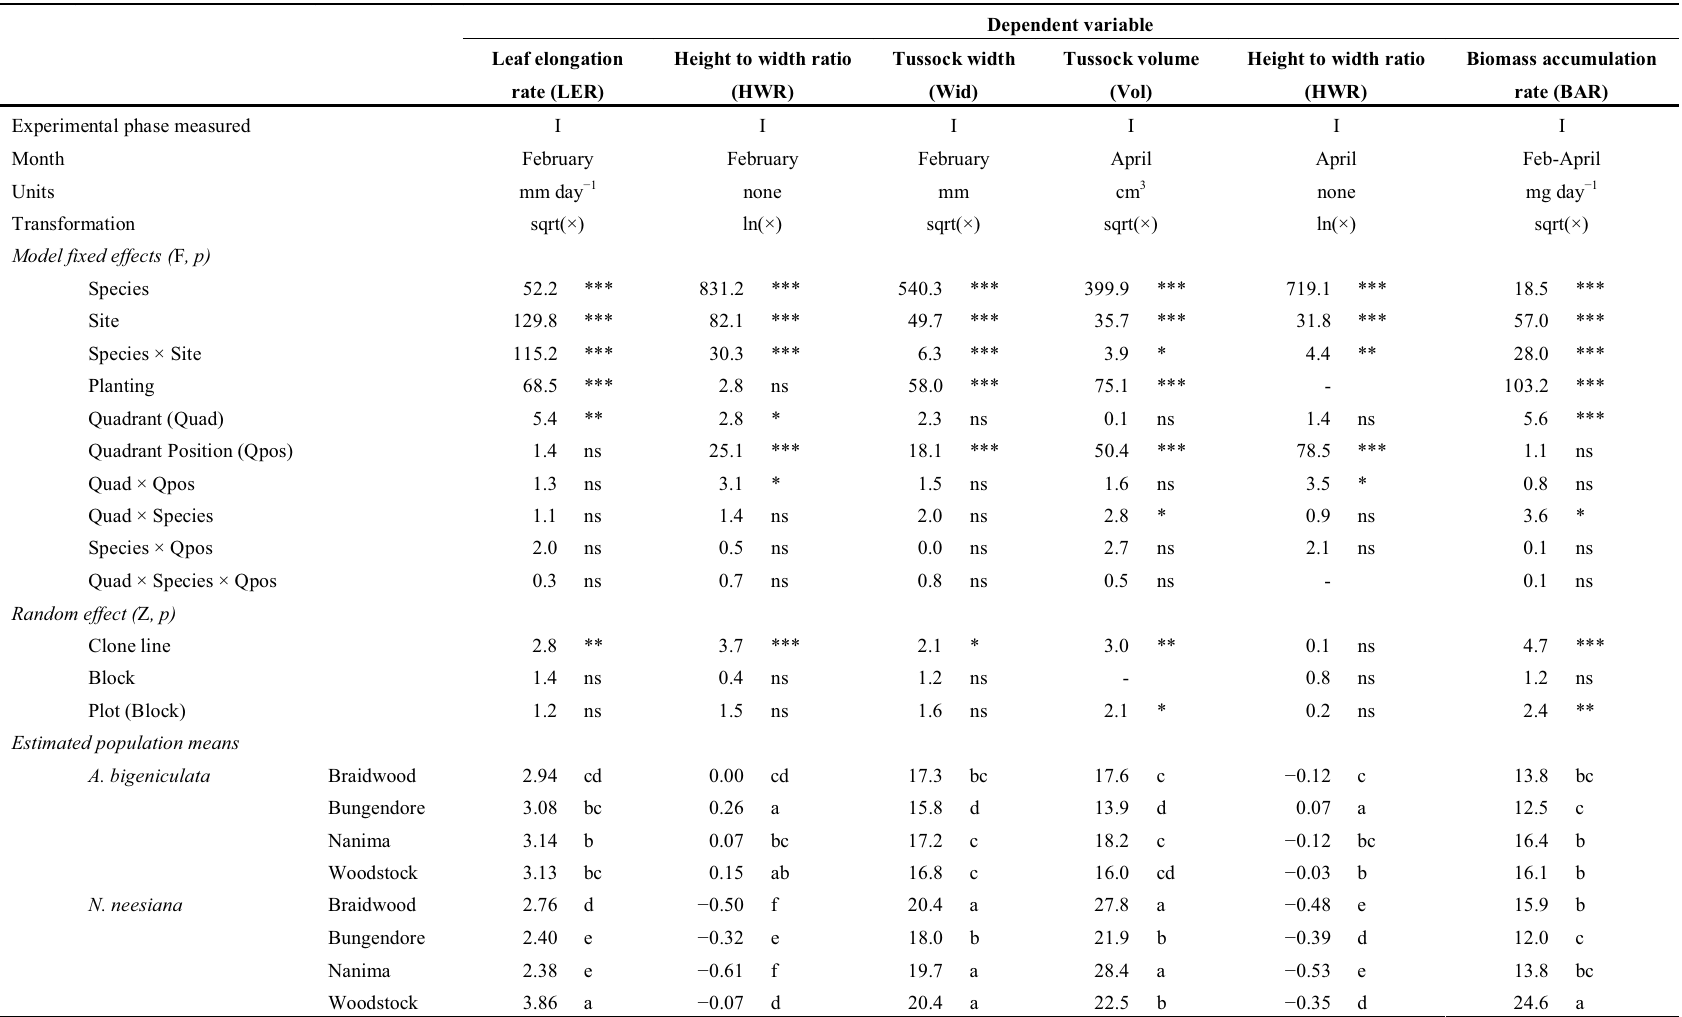
Table 2. Results of linear mixed model analysis of trait data collected during Phase I of the experiment. Data in columns adjacent to fixed variables are F and associated p values (*** = p < 0.001; ** = p < 0.01; * = p < 0.05, ns = p (cid:149)(cid:3) (cid:19)(cid:17)(cid:19)(cid:24)(cid:12) ; for random variables Z and p are provided. Estimated population means sharing the same letter did not differ at the 0.05 significance